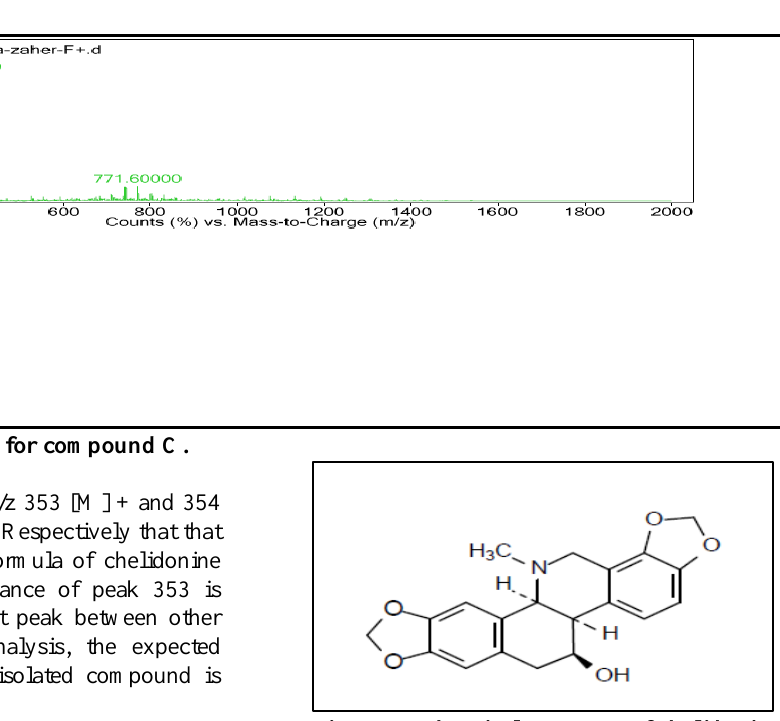
Figure 13. chemical structure of chelidonine. The ʎmax spectrum and FTIR chart for compound C were shown in figure 14, 15 and table